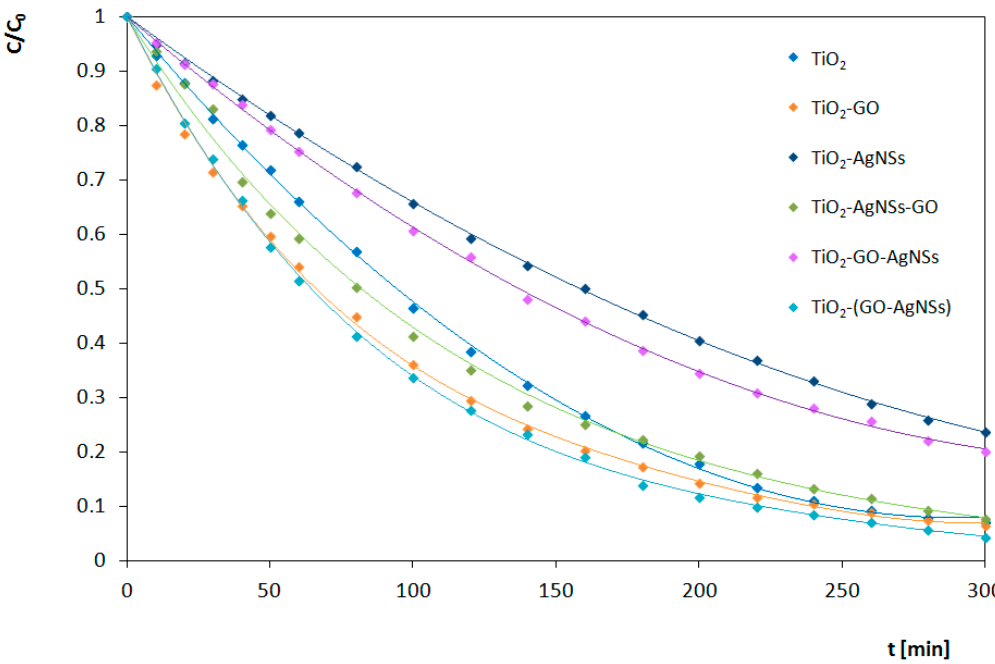
Figure 11. Photocatalytic degradation of RhB under Vis irradiation in the presence of prepared photocatalysts. Table 2. Reaction rate constants estimated for coatings with defined architecture, established for UV and Vis radiation and conversion efficiency of RhB transformation calculated for process under Vis irradiation.